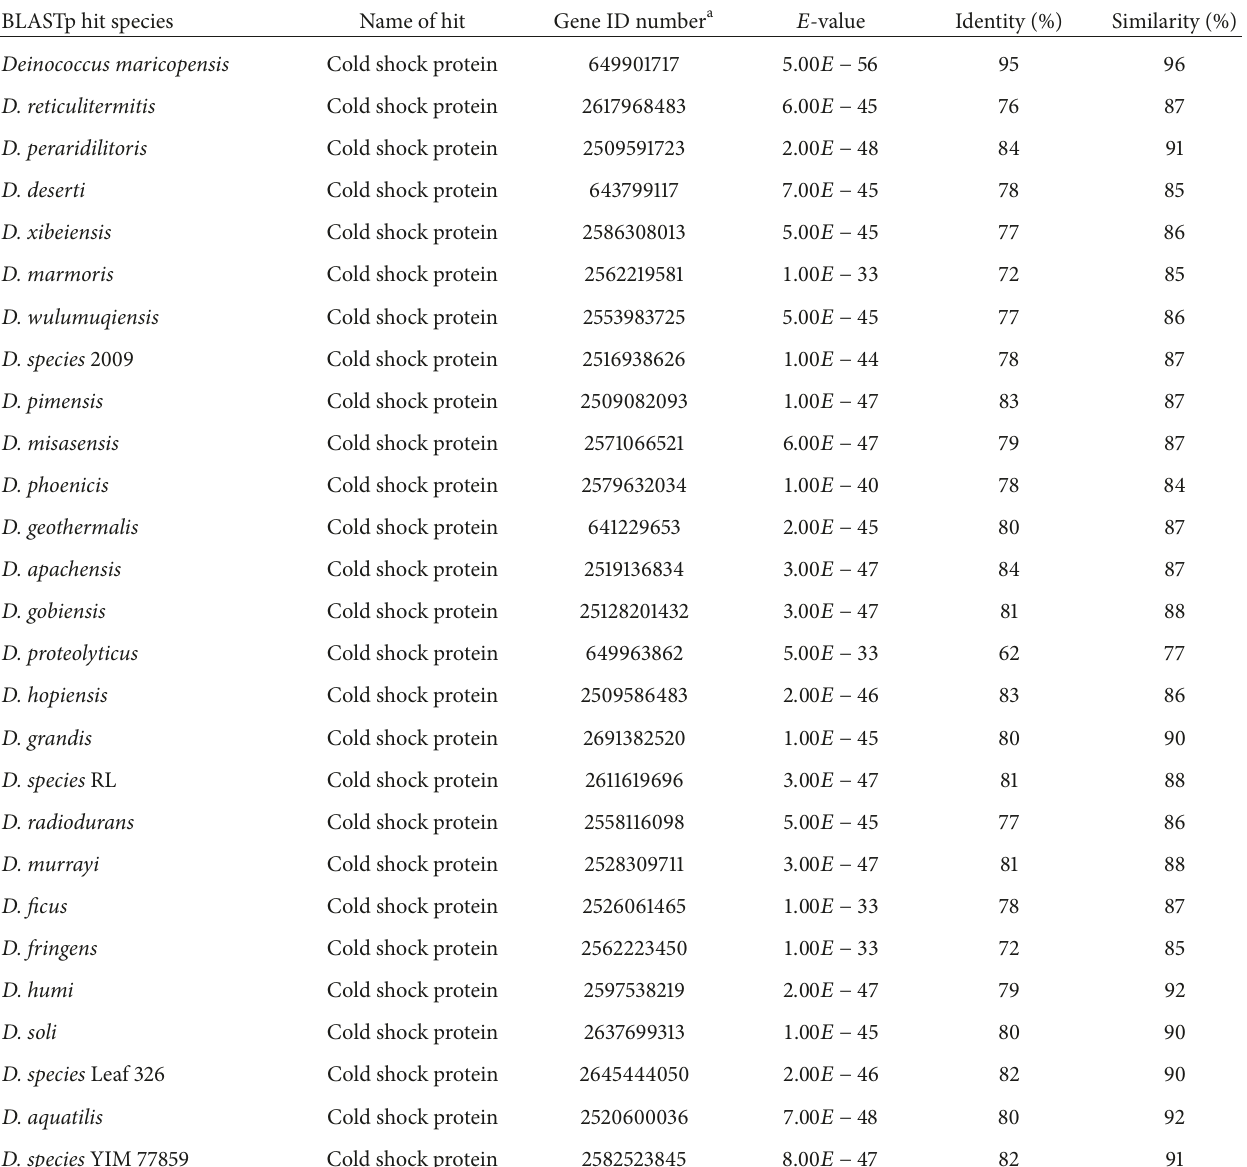
Table 3: BLASTp analysis of Dm-Csp1 (NCBI Accession #WP 013556416.1) versus deinococci